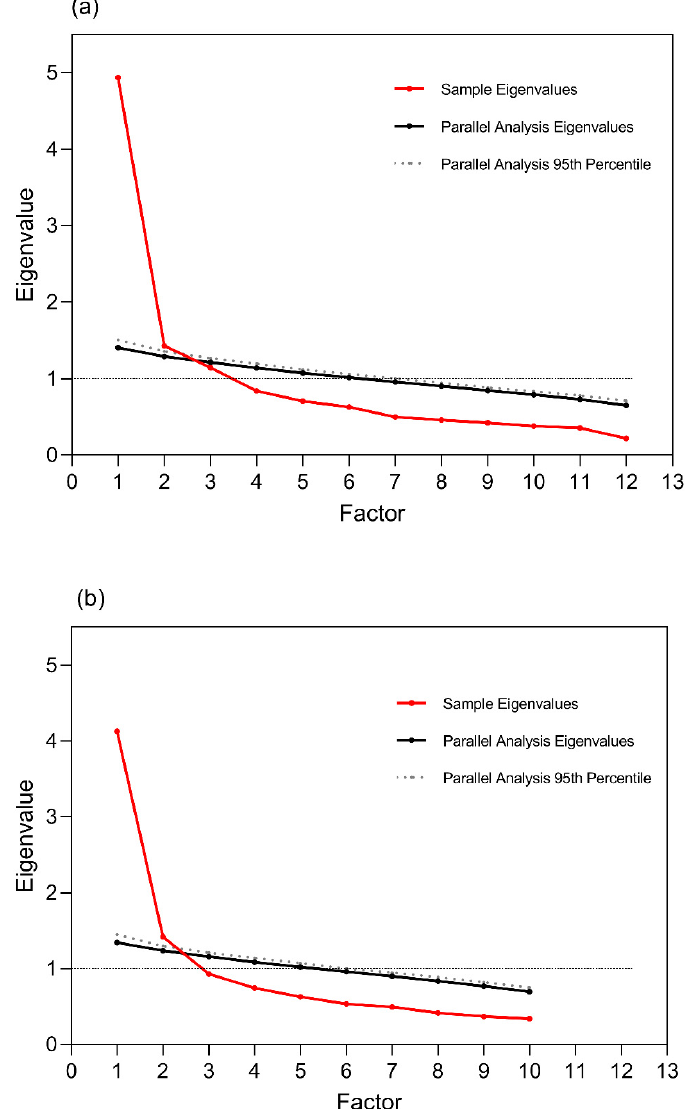
Figure 1. Parallel analysis of the MEQ-C-C. ( a ) Parallel analysis with 12 items; ( b ) parallel analysis without items 9 and 10.